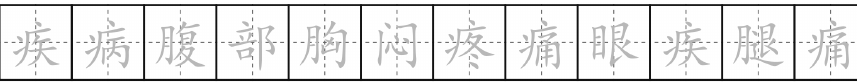
Figure 3. Schematic diagram of the Tianzi lattice.